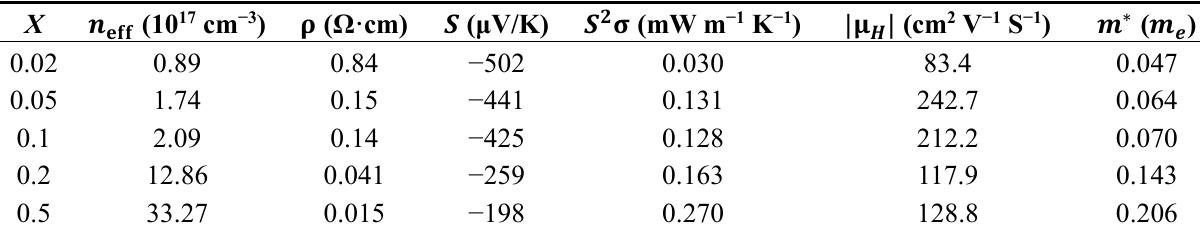
, electrical resistivity ρ , Seebeck coefficient S , (cid:2915)(cid:2916)(cid:2916) | , and effective mass of electron (cid:1865) ∗ of (cid:3009)